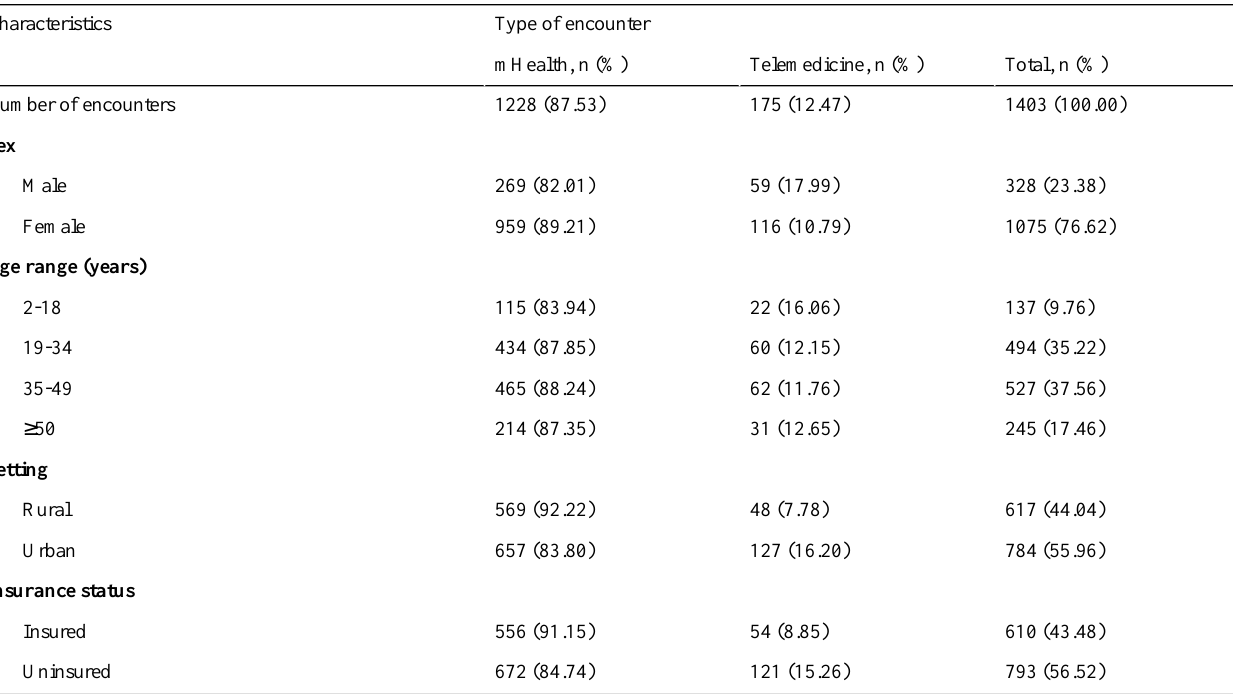
Table 1. Demographics of Virtual Urgent Clinic users.